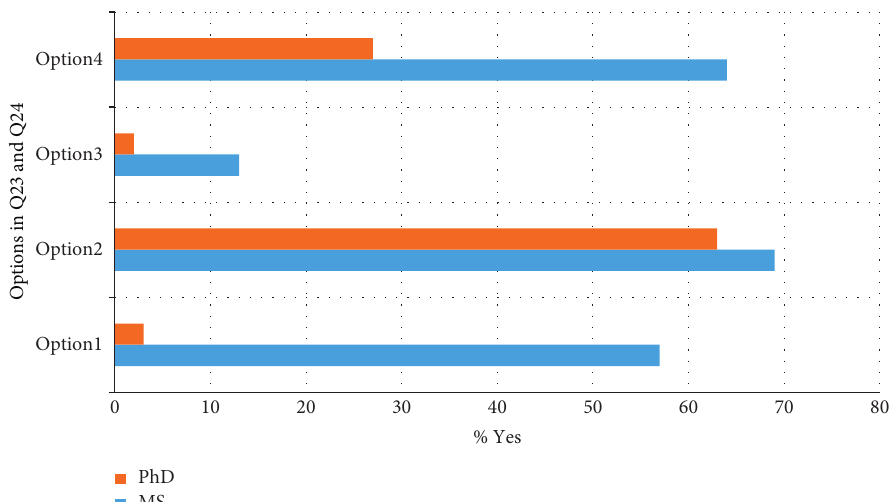
Figure 3: Percent of responses on the relationship between originality and publishability in response to question nos. 23 and 24 of